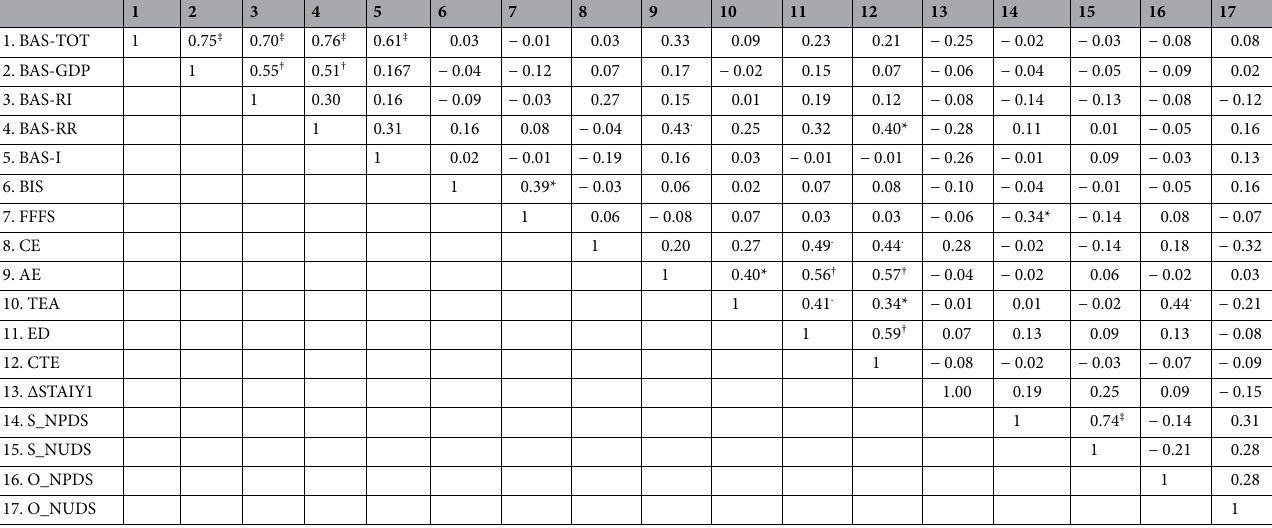
Table 4. Partial correlations for RST-PQ , ECQ personality traits, and Control minus Placebo for State- Anxiety difference scores (∆STAI-Y1), numerical pain and distress rating difference scores, repectively in